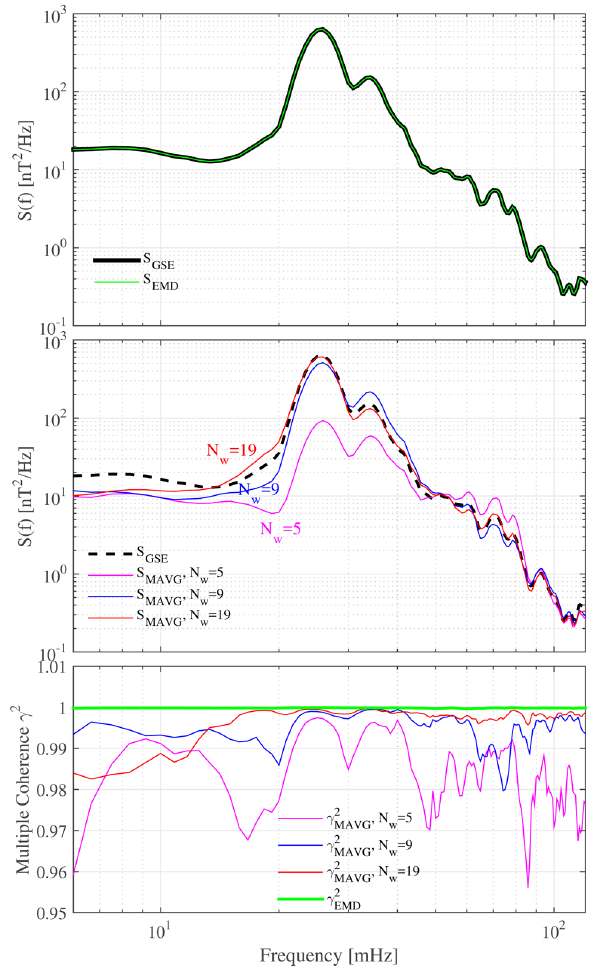
Figure 11. Power spectral density S obtained by means of EMD al- gorithm (top panel, green line) and by means of MAVG algorithm (marked with different colors, cen- (central panel) using different N w tral panel), together with the total power spectra S of GSE compo- nents (black lines). (bottom panel) The multiple coherence c 2 between GSE and MFA components using EMD (green) and MAVG (with different